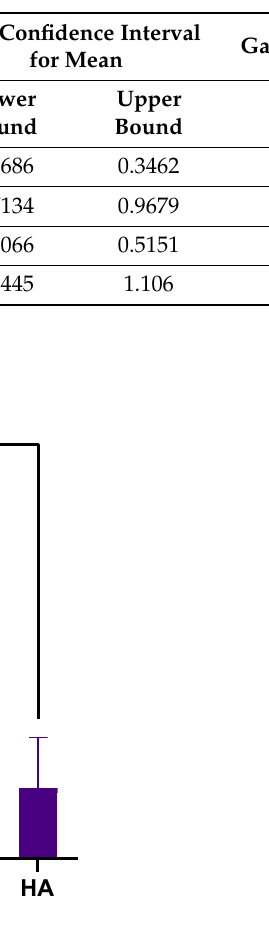
Figure 2. Overall fold-change values (mean ± SD) for all genes combined. >0.05 (ns), ≤ 0.05 (*), ≤ 0.01 (**), ≤ 0.001 (***), ≤ 0.0001